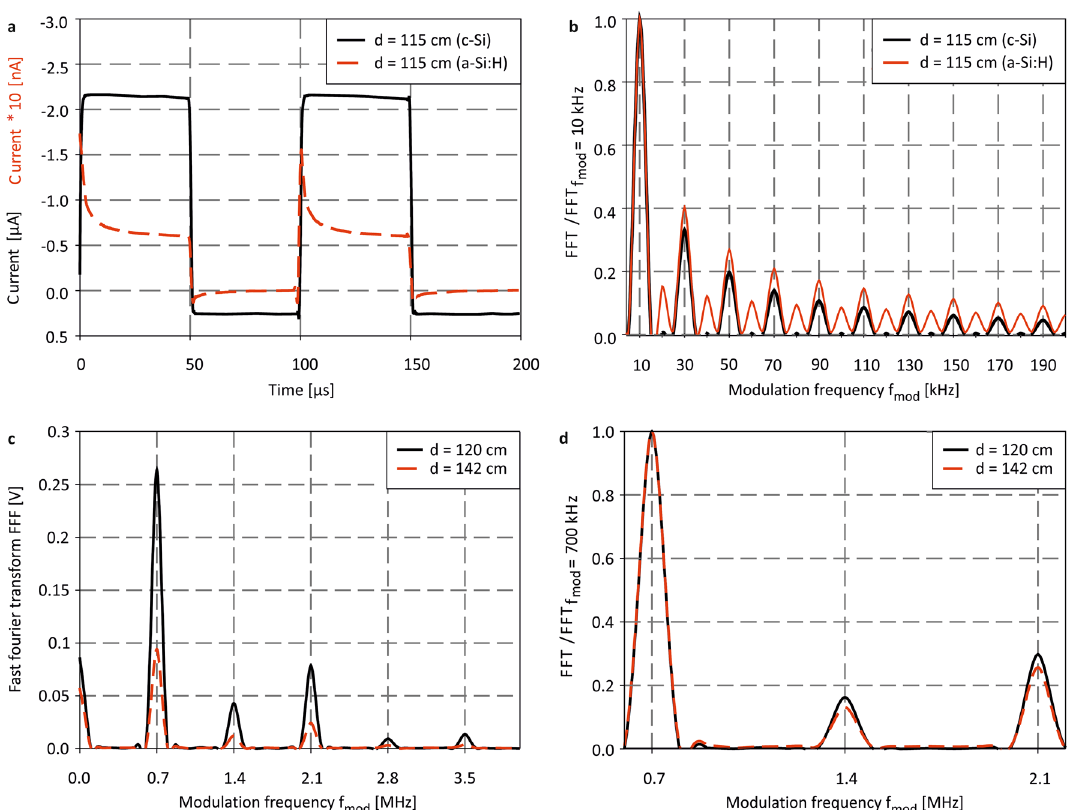
Figure 3. ( a ) Time-domain and ( b ) normalized absolute FFT amplitudes of c-Si (black) and a-Si:H (red) at d = 115 cm , 477 nm and 0 V bias . In ( b ), the signals have been normalized on the peak amplitude at f mod . Independent from irradiance and distance, normalized absolute FFT amplitudes at the harmonic frequencies ( 2 · n + 1 ) · f mod remain constant for the c-Si detector. Nonlinear beat frequencies only occur in the a-Si:H FIP detector due to signal overshoots at the rising and falling edges of the transient detector response. ( c ) Absolute FFT signals recorded at d = 120 cm and d = 143 cm for f mod = 700 kHz , 0 V bias and 477 nm , and ( d ) absolute FFT signals normalized on f mod = 700 kHz verifying an amplitude distinction at 2.1 MHz , enabling unambiguous distance